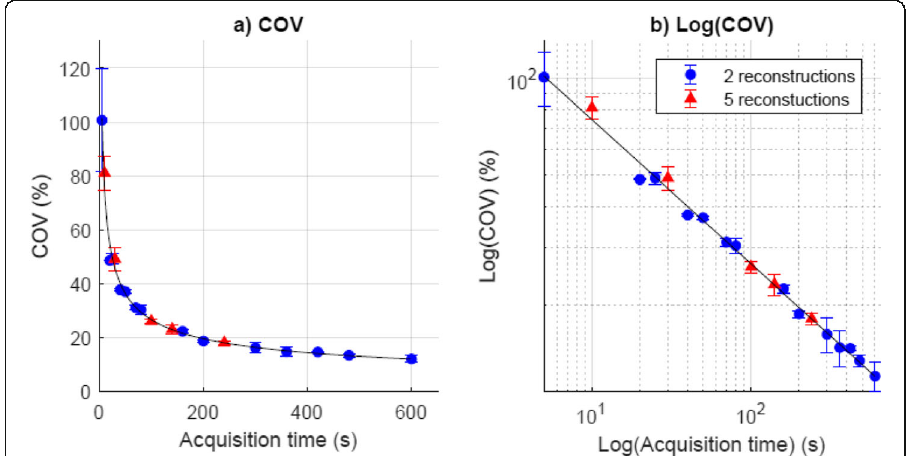
Fig. 4 Coefficient of variation (COV) in the phantom background compartment of both, P1 and P2 reconstructions at different acquisition times, in graphs with a standard scale and b log-log scale. A power- law fit resulted in COV = 208 T − 0.446 . The coefficient of determination r 2 equals 0.99, which indicates a good